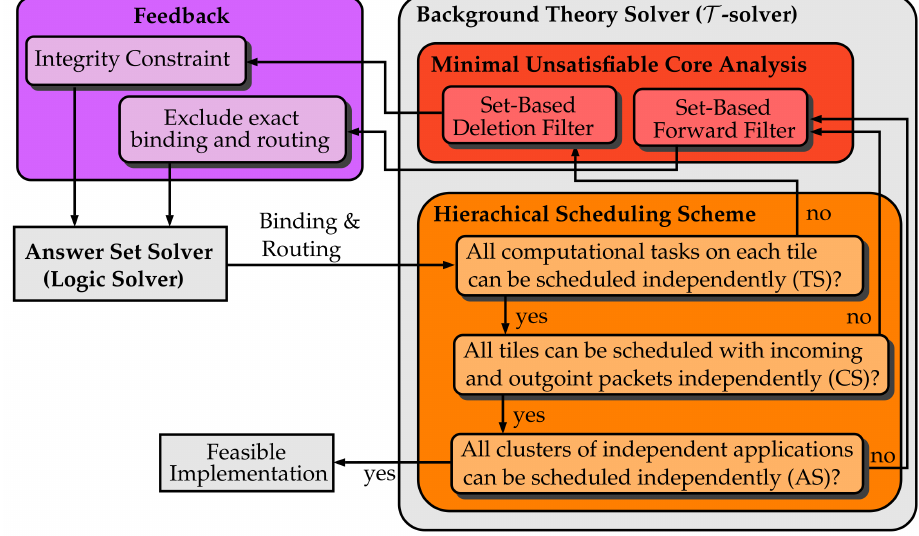
Figure 5. Detailed overview of the flow within the coupling of the answer set solver and the background theory